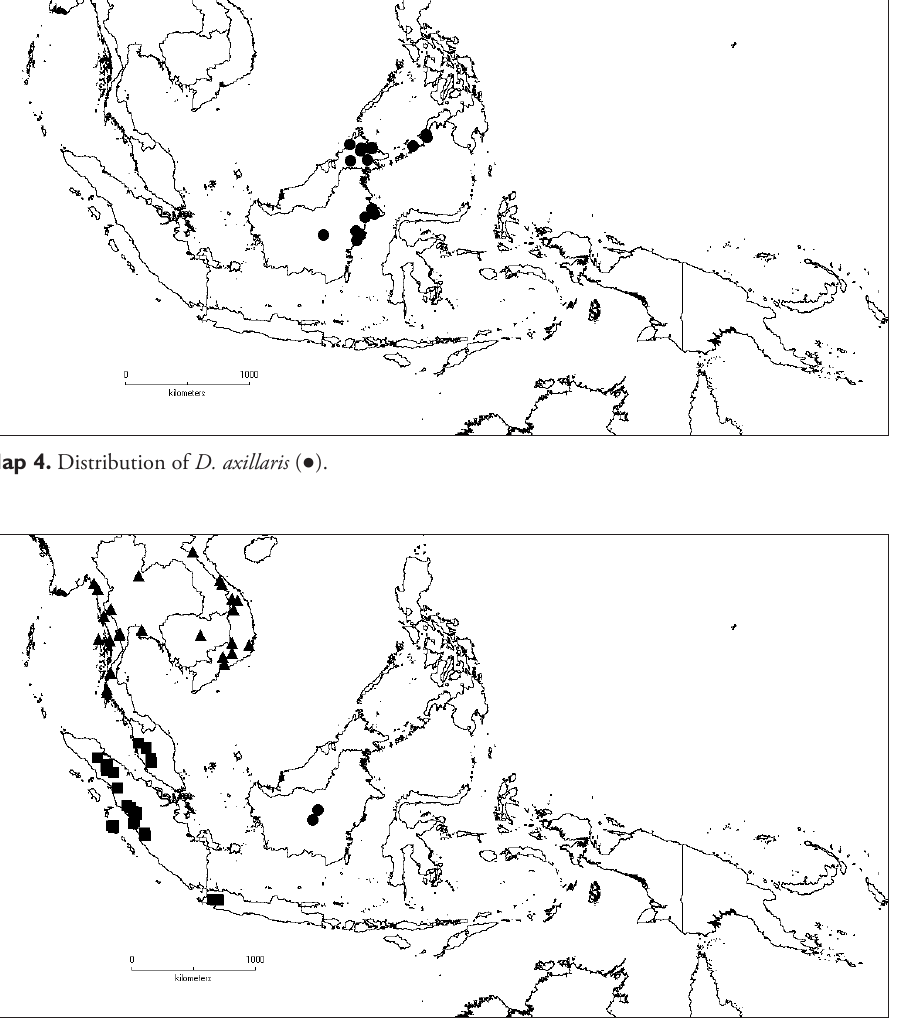
Map 5. Distribution of D. atrobrunnea ( ● ), D. bakhuizenii ( ■ ) and D. barbata ( ▲